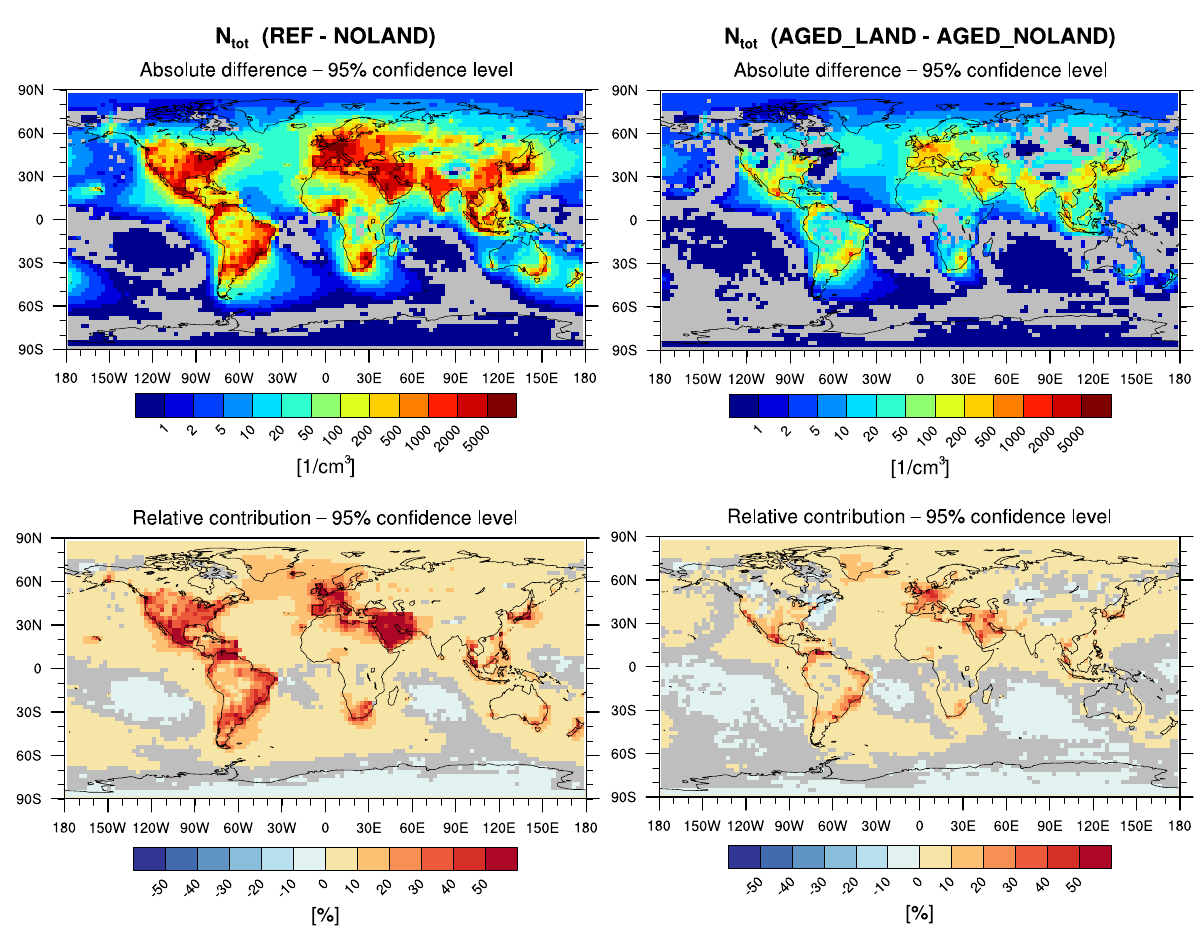
Fig. 8. Multi-year average (1996–2005) of the absolute (top) and the relative effect (bottom) of land transport on the Aitken and accumu- lation mode particle number concentration at the surface. Plotted are the differences between the experiments AEROCOM_LAND (REF) and NOLAND (left) and between AGED_LAND and AGED_NOLAND (right). The relative effect is calculated as the relative contribu- tion (REF–NOLAND)/REF (left) and (AGED_LAND–AGED_NOLAND)/AGED_LAND (right). Grid points where the difference is not statistically significant according to a uni-variate t test (5% error probability) are masked out in